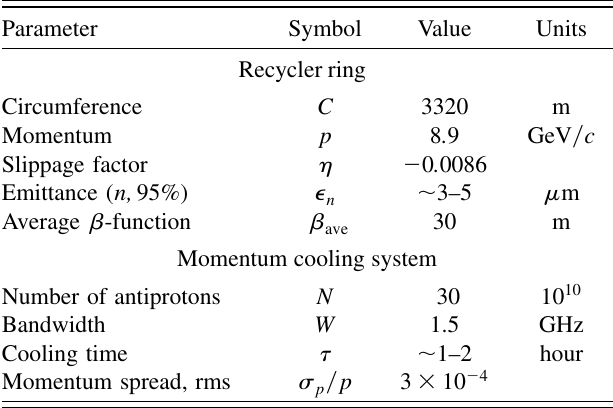
FIG. 2. The measured time domain longitudinal bunch distribution (solid line, arbitrary units) and the barrier-pulse rf waveform (dashed line, 4 kV peak-to-peak) for antiprotons in the Recycler for one revolution For the parabolic-bucket data of Fig. 3, the fitted values are (cid:6) 13 : 39MeV 2 = h . The final (equilib- (cid:3) (cid:6) 0 : 86 h (cid:2) 1 , D SC = 2 (cid:3) (cid:5) 1 = 2 (cid:6) 2 : 79 MeV . The rium) energy spread is (cid:4) D SC numerical fit errors do not exceed 1%. TABLE I. Recycler